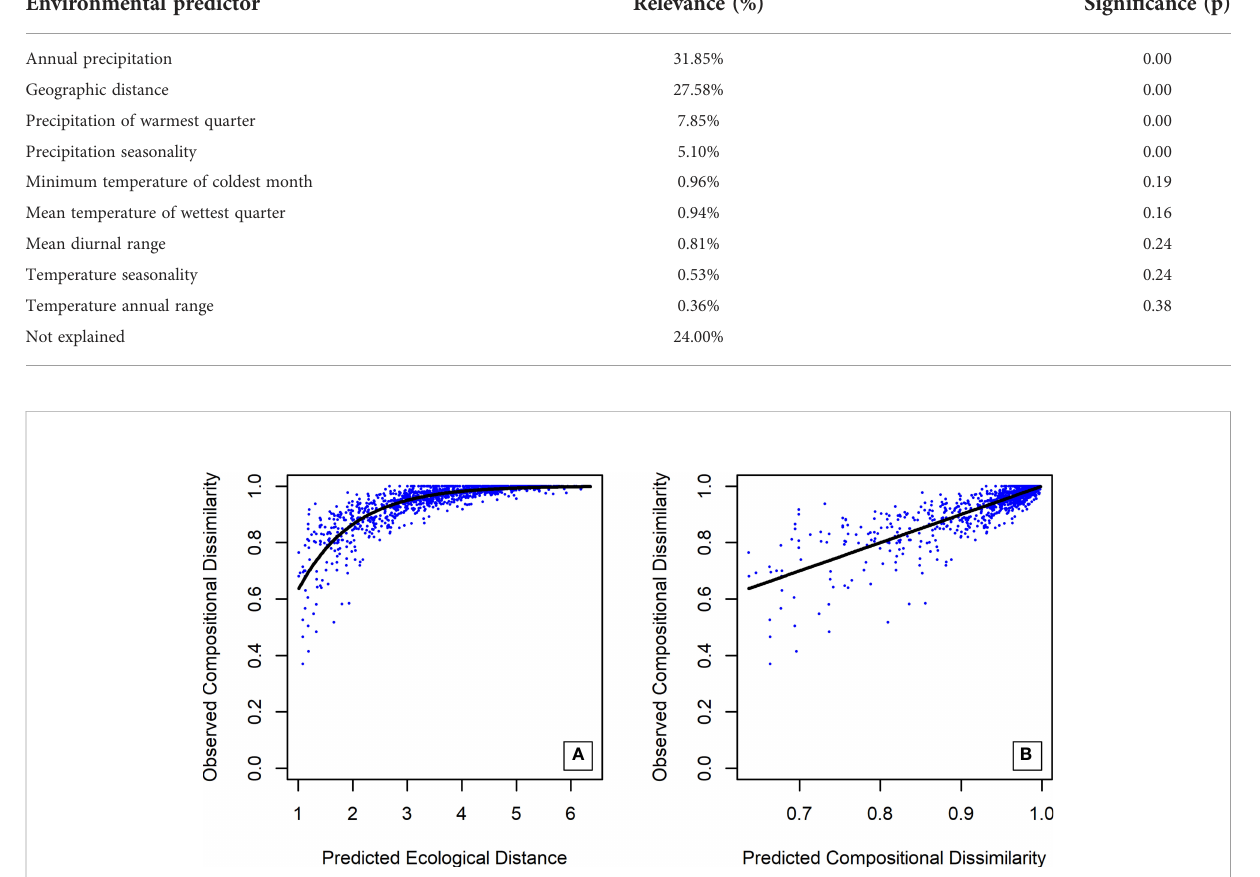
TABLE 1 Predictors included in the generalized dissimilarity models, their proportional relevance for species turnover and statistical signi fi cance. Environmental